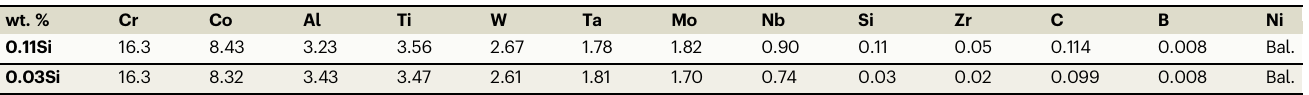
Table 1 | Chemical compositions of two IN738LC powders with different Si concentrations in weight percentage wt.